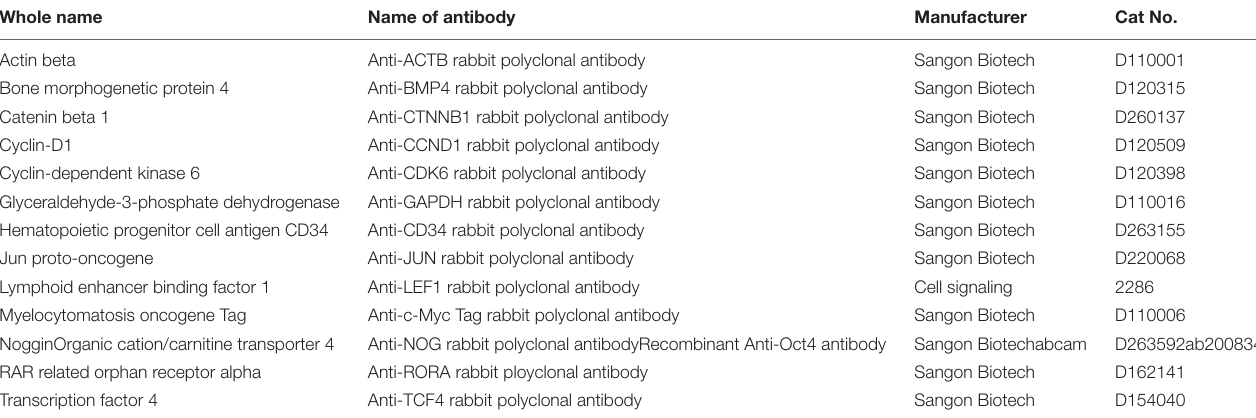
TABLE 2 | List of antibodies used for Immunofluorescence analysis and western